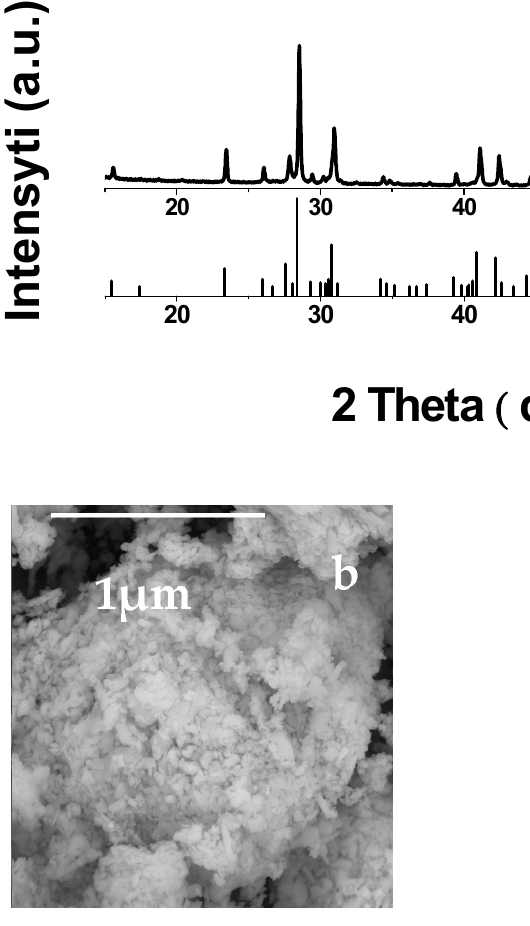
Figure 3. ( a )-( 1 ) XRD pattern of Li 1.3 V 3 O 8 synthesized in this work and ( 2 ) line diagram of powder Figure 3. ( a )-(1) XRD pattern of Li 1 . 3 V 3 O 8 synthesized in this work and (2) line diagram of powder pattern for LiV 3 O 8 standard in PDF-2 database, No. 72-1193. ( b ) SEM image of Li 1.3 V 3 O 8 pattern for LiV 3 O 8 standard in PDF-2 database, № 72-1193. ( b ) SEM image of Li 1 . 3 V 3 O 8 sample.